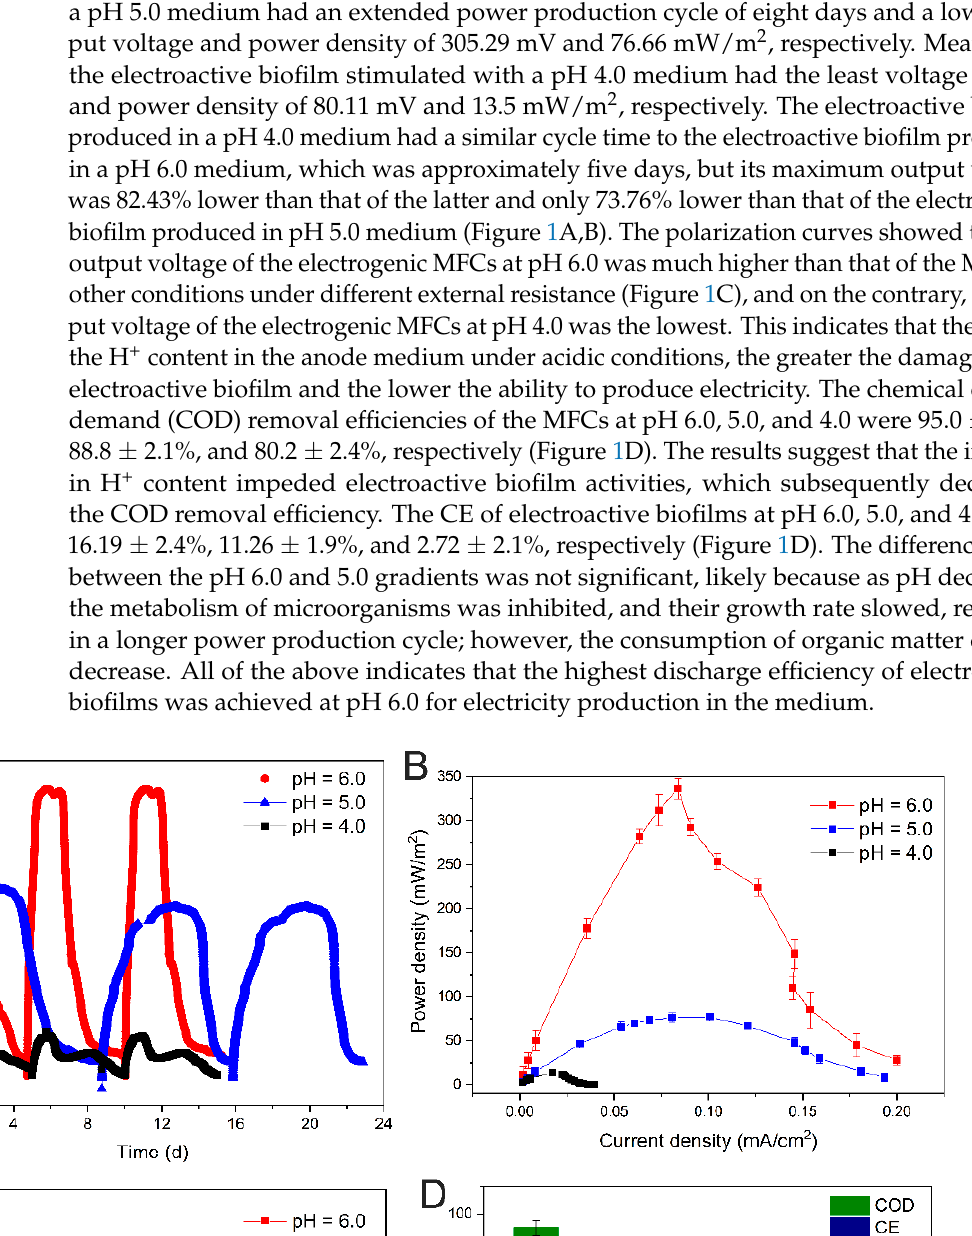
Figure 2. EIS of MFCs under different pH conditions. 3.2. Observation of Electroactive Biofilm Morphology at Different Low pH Previous studies on MFCs have shown that the bacterial species, abundance, and ac- tivity in the anode biofilm mainly affect the power generation performance of the MFCs [38]. Figure 3 shows SEM images of anode carbon brushes before system start-up and after stable operation of MFCs at different pH conditions. Before system operation, the anode carbon fibers were arranged in an orderly manner, and all surfaces were relatively clean and smooth without microorganisms attached (Figure 3A). The carbon fibers of the anode